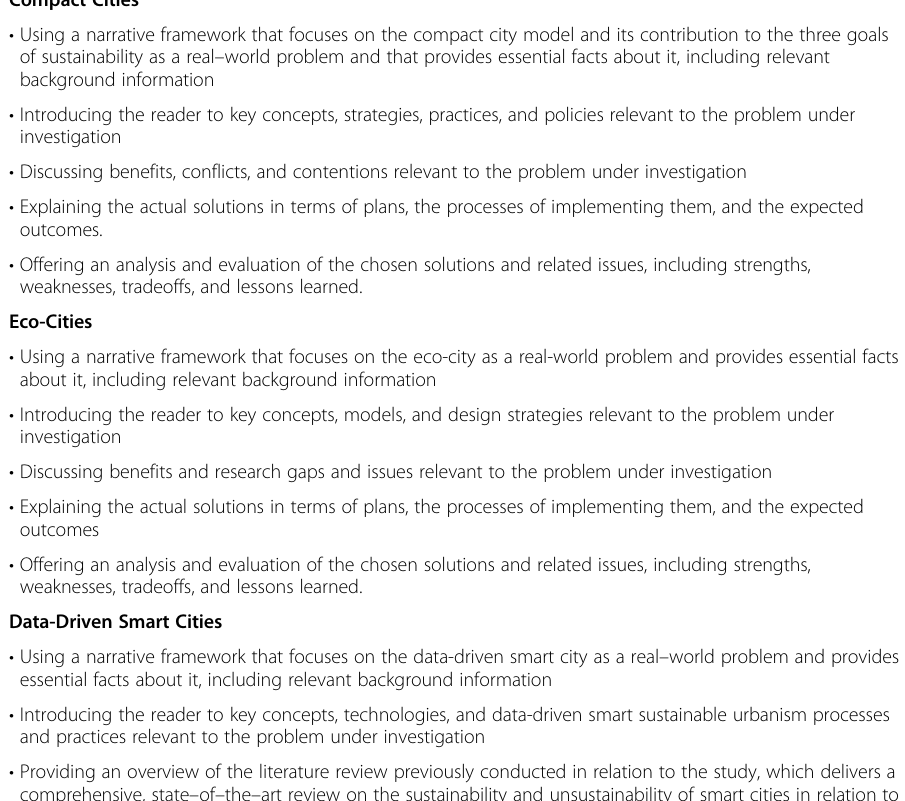
Table 2 A five-step process tailored to the four case studies conducted Compact Cities (cid:129) Using a narrative framework that focuses on the compact city model and its contribution to the three goals of sustainability as a real – world problem and that provides essential facts about it, including relevant background